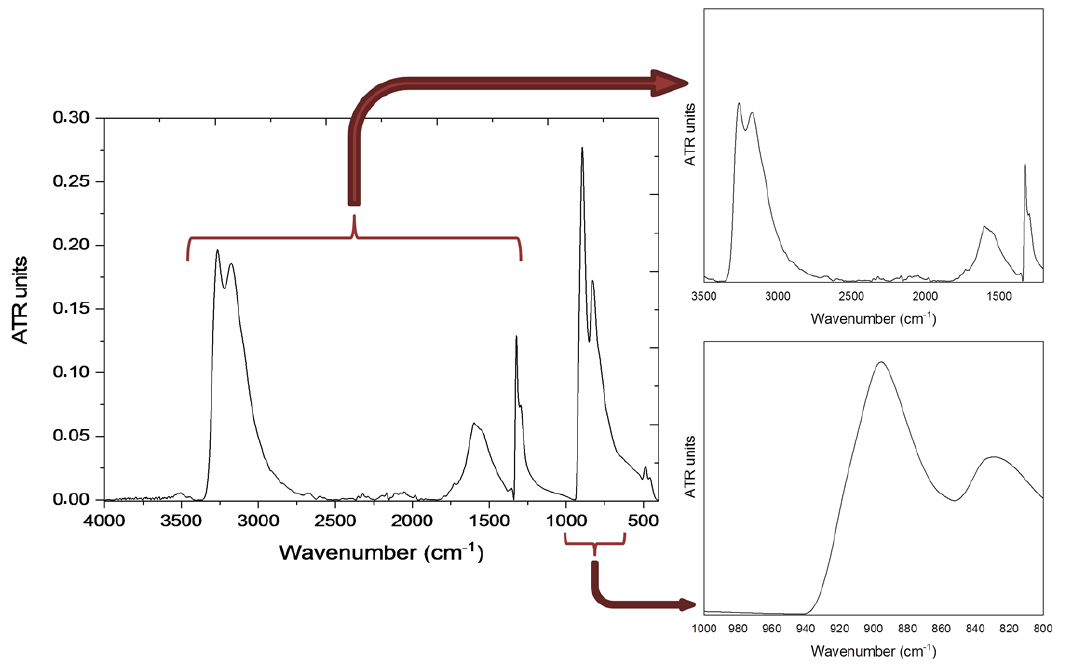
Figure 5. IR spectrum of compound 3-Mn in the range of 4000 – 400 cm -1 at room temperature. The low-temperature Raman spectra for compound 3-Mn were recorded in the range of 1000 – 200 cm -1 (Figure 6).